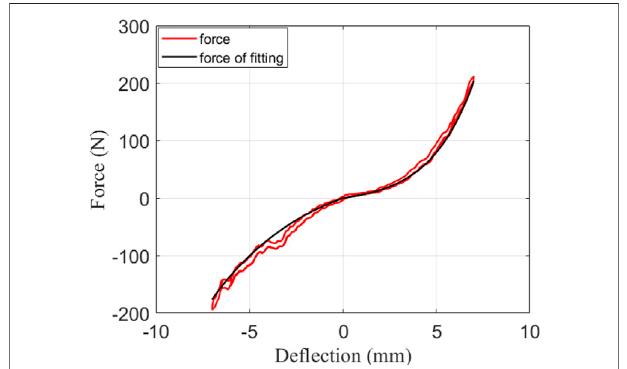
FIGURE 3 | Force-de fl ection curve fi tting